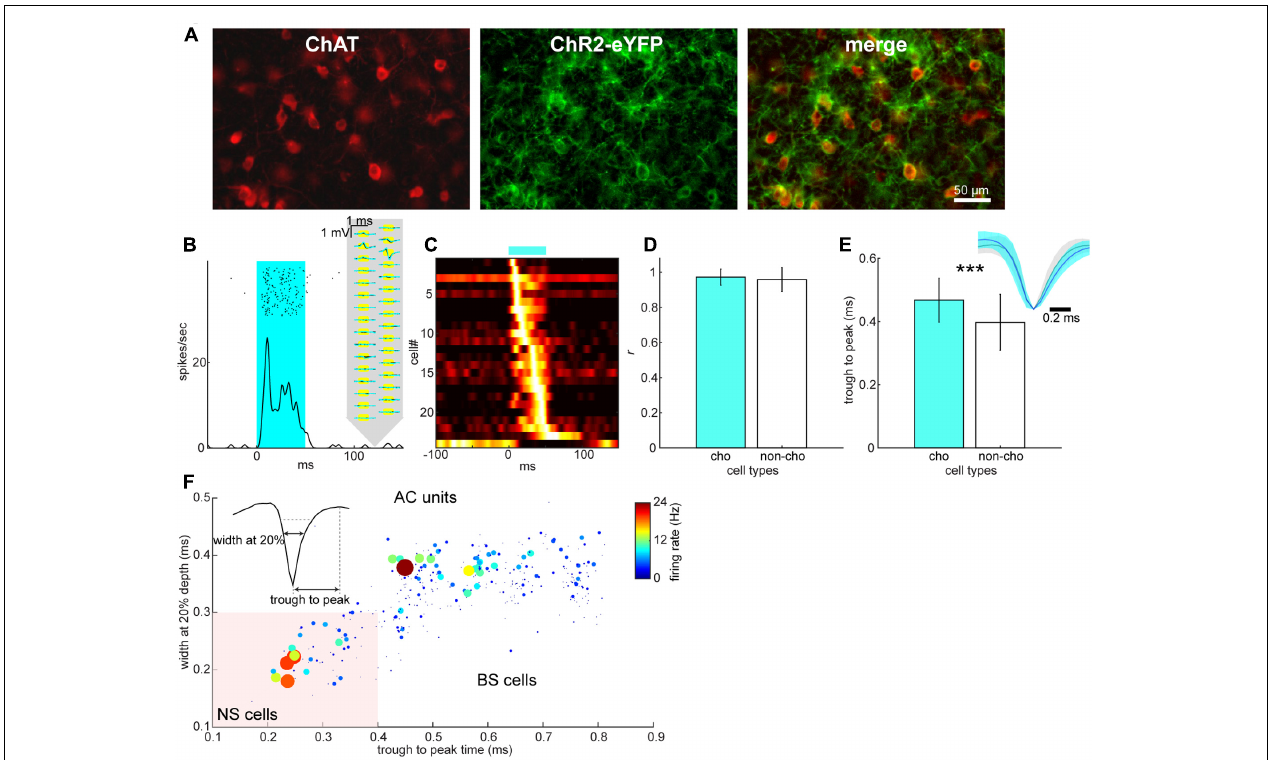
FIGURE 3 | Cell type classification in the BF and AC. (A) Expression of ChR2-EYFP in choline acetyltransferase (ChAT)-positive neurons of the BF. (B) An example of optical evoked responses in the BF. Spike raster and peri-stimulus time histogram (PSTH) show responses to an optical stimulation (shaded in cyan). Spontaneous (black) and optically evoked (cyan) average spike waveforms are also shown on the schematics of silicon probe. (C) A summary of normalized optical evoked responses. Each PSTH was normalized by the peak spike rate and color-coded. Of 24 significantly modulated neurons, one neuron showed suppression although this neuron was categorized as a non-cholinergic neuron. (D) Assessment of spike waveform distortion by measuring Pearson’s correlation coefficient with in the population of cholinergic (cho) and non-cholinergic (non-cho) neurons. No significant difference in correlation coefficient between cell types was detected ( t 330 = 0.93, p = 0.35, Student’s t -test). (E) Comparison of trough to peak time of average spike waveforms between cholinergic and non-cholinergic neurons ( t 355 = 3.72, p = 0.00023). Inset: normalized average spike waveforms for cholinergic (blue) and non-cholinergic neurons (black). (F) Cell classification of broad-spiking (BS) and narrow-spiking (NS, shaded area) cells based on average spike waveforms. Average spontaneous firing rate is also color-coded with linearly scaled dot